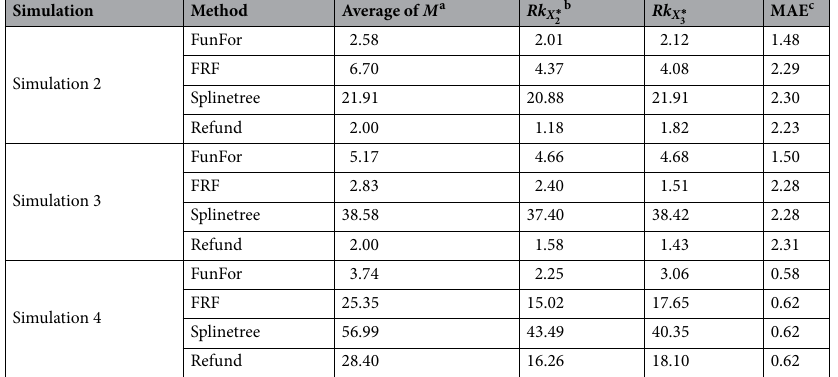
Table 2. The variable selection and prediction performances of the four approaches for the Simulation Examples 2–4. a The average of M is the average of the minimum selection size that requires to obtain all of the true predictors across 100 replications. The smaller, the better. predictor across 100 replications. The smaller, the better.